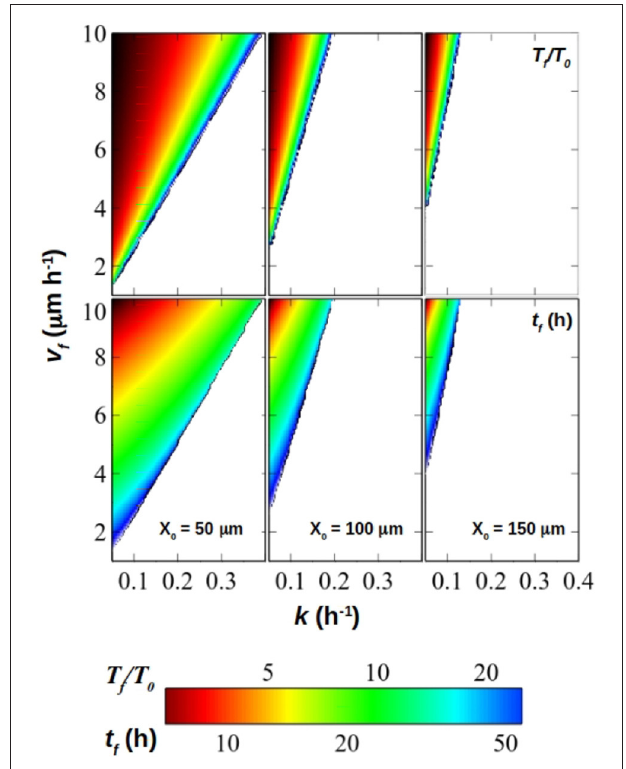
FIGURE 8 | Relative final size of the eye ( T f / T 0 , top panel) and eye termination time ( t f , bottom panel) for primordium width X 0 = 50 µ m (left column), 100 µ m (middle column) and 150 µ m (right column) for values of k ∈ [0.05,0.4] h − 1 and v f ∈ [1,10] µ mh − 1 calculated with Equations (18, 17). The scale both for T f / T 0 and t f is display in the